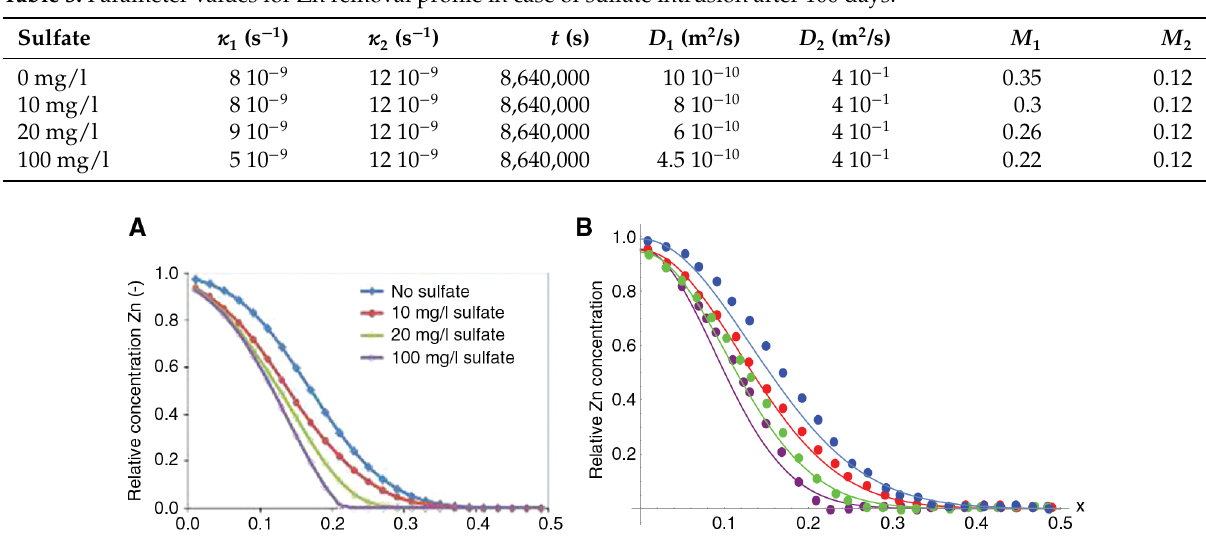
Table 3: Parameter values for Zn removal profile in case of sulfate intrusion after 100 days.